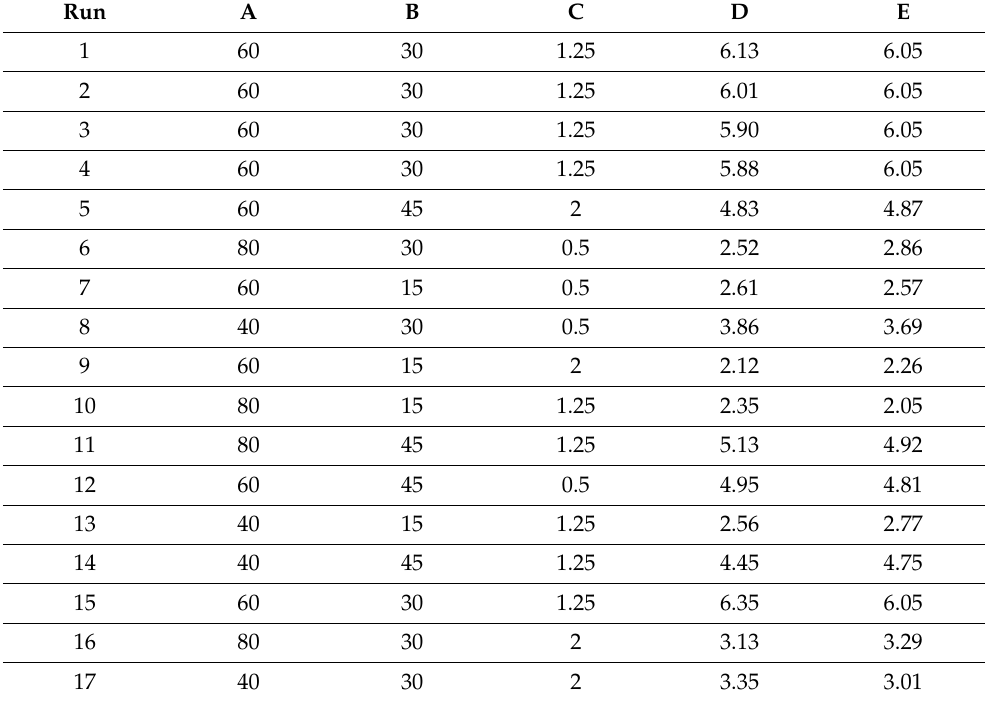
A: Carbonation temperature ( ◦ C), B: Carbonation time (min), C: H 2 O-to-CO 2 ratio, D: is actual CO 2 adsorbed (mmol